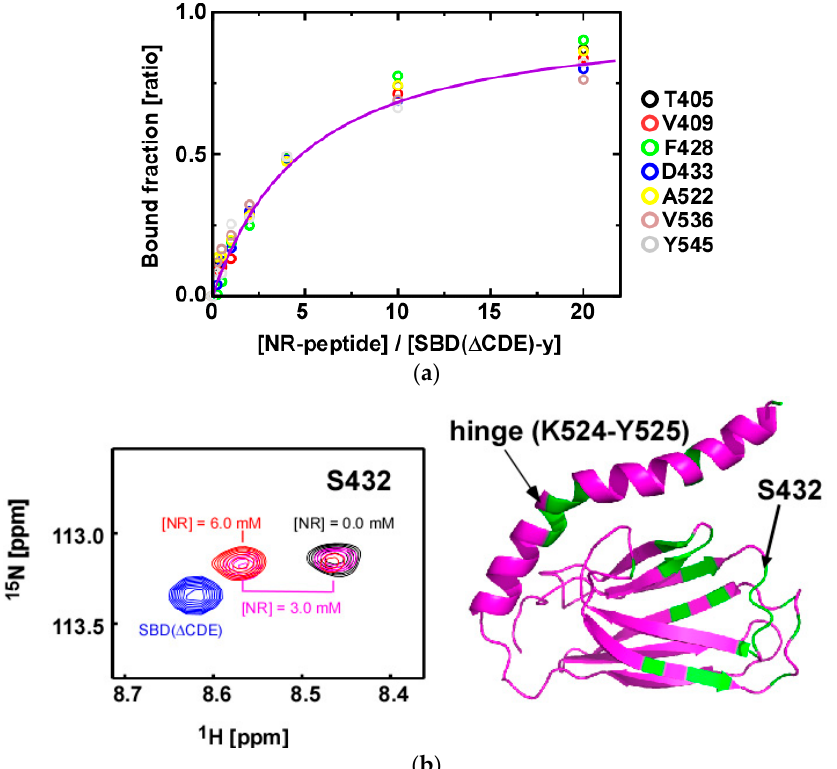
Figure 5. NR-peptide binding to SBD( ∆ CDE)-y of human Hsp70. ( a ) Determination of the binding affinity of the NR-peptide to SBD( ∆ CDE)-y by measuring NMR signal intensity changes in 2D 1 H- 15 N HSQC spectra for the listed residues examined in the NR-peptide titration. Global fitting the bound fractions of the listed residues gave a K D = 1.3 ± 0.1 mM; ( b ) A representative change in resonance intensities observed during the NR-peptide titration with SBD( ∆ CDE)-y. Data for S432 is shown ( left ). When the NR-peptide concentration ([NR]) is 3.0 mM and 0.3 mM SBD( ∆ CDE)-y is present there are signals observed for both the bound and free states (magenta). At [NR] = 6.0 mM, only the bound state signal for S432 is observed (red). For comparison, the 2D 1 H- 15 N HSQC signal for S432 in SBD( ∆ CDE) (intramolecular α B bound form) is shown in blue. Residues showing significant spectral changes observed at [NR] = 1.2 mM are mapped onto the solution structure of SBD( ∆ CDE)-y ( right ).